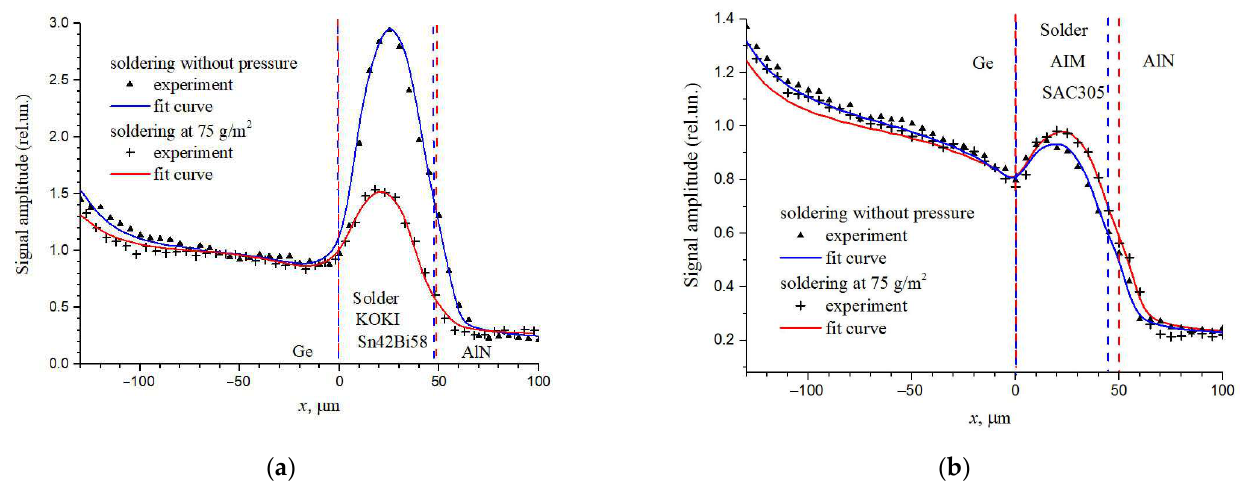
Figure 8. Amplitude of the PBD signal across the solder joint between the Ge wafer and the AlN ceramics: ( a ) solder KOKI; ( b ) solder AIM. Dash lines are solder layer boundaries. Adapted with permission from [75]. Copyright (2022), Ioffe Institute.